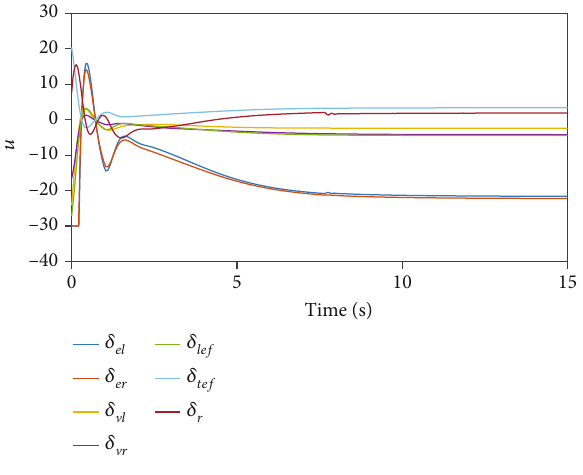
Figure 12: The responses of actuator of fi ghter 3.